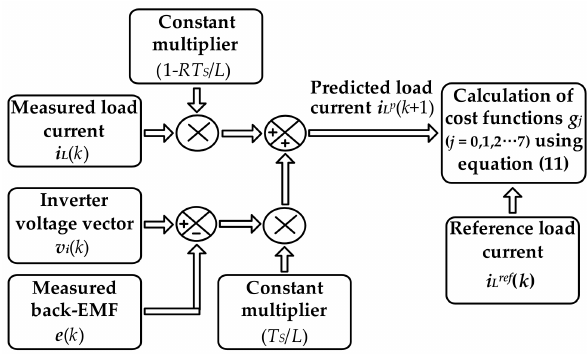
Figure 4. Block diagram for computation of the cost function.